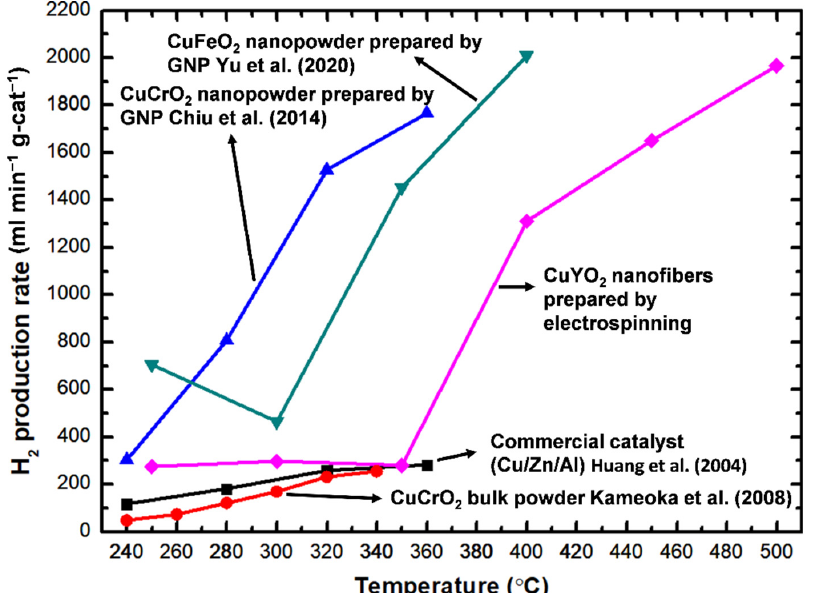
Figure 11. Hydrogen production results of CuYO 2 nanofibers (electrospun), CuCrO 2 (GNP) [29], CuFeO 2 (GNP) [37], CuCrO 2 (solid-state method) [38], and commercial catalysts [27].